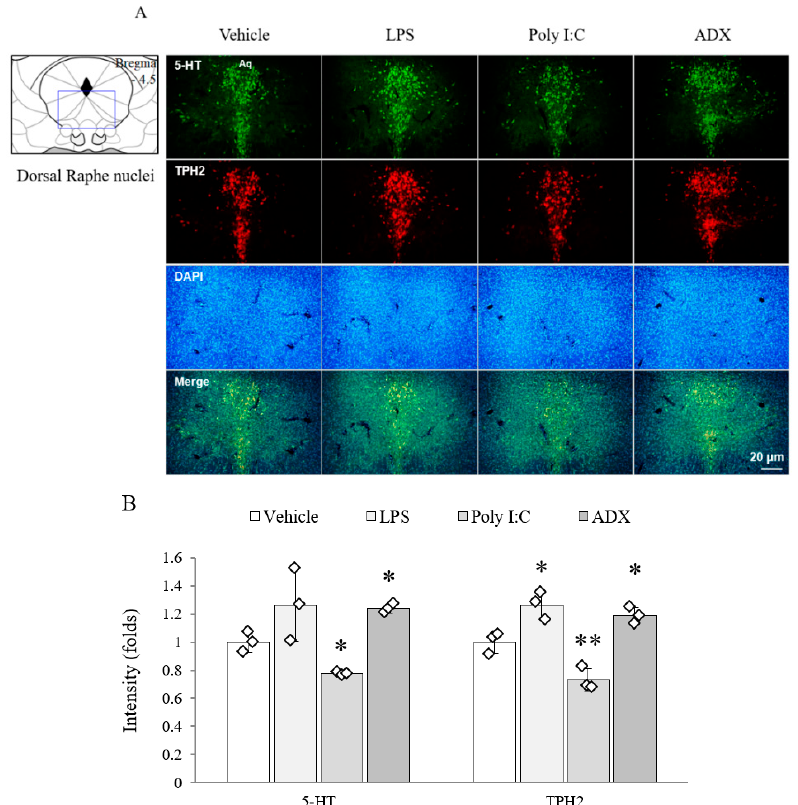
Figure 4. The 5-HT and TPH2 in the raphe nuclei of the brain. The 5-HT- and TPH2-positive double stained cells in the dorsal raphe nuclei ( A ). Representative photomicrographs were taken at magnifications of 100 × . Quantification of 5-HT and TPH2 ( B ). Data are expressed as the means ± SD ( n = 3). *, p < 0.05; **, p < 0.01 compared with the vehicle group. 5-HT; 5-hydroxytryptamine, TPH2; tryptophan hydroxylase, DAPI; 4 ′ ,6-diamidine-2-phenylindole dihydrochloride.